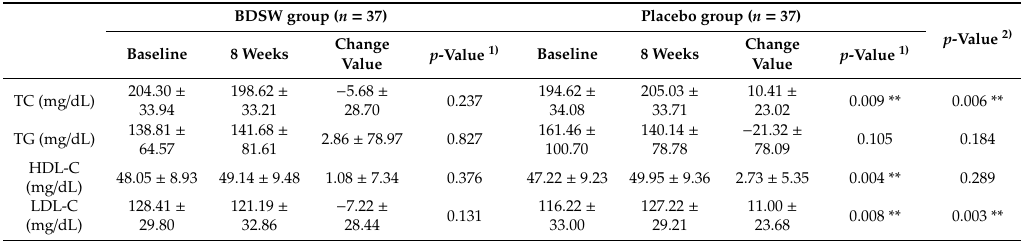
Table 6. Changes in blood lipid profile before and after ingestion.